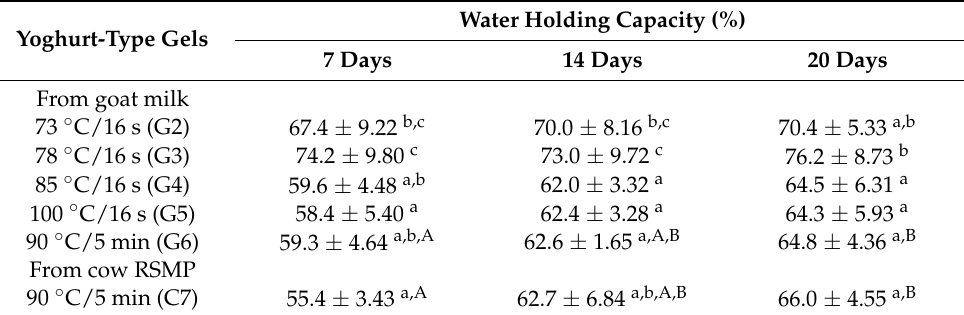
Table 5. Water holding capacity (WHC, %) during the storage of yoghurt-type gels made from heat-treated homogenized goat milk at 43 ◦ C; means ± standard deviation. Reconstituted cow skim milk powder (RSMP) treated at 90 ◦ C for 5 min was used as